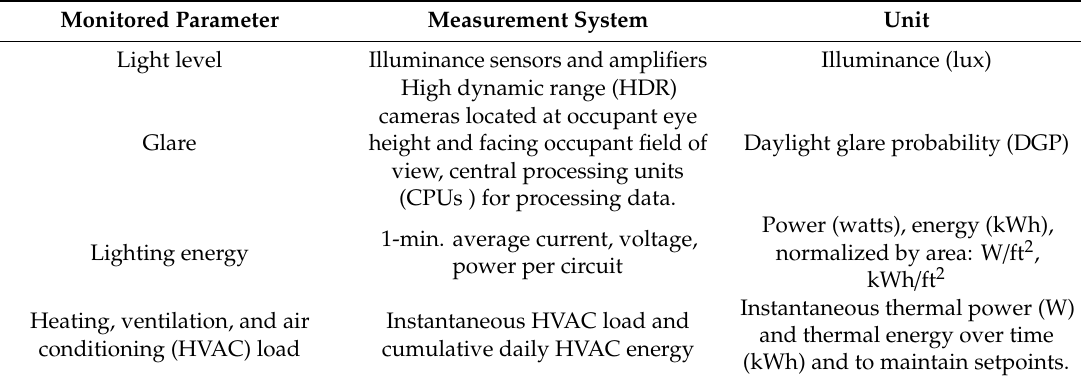
Table 2. Measured performance parameters.